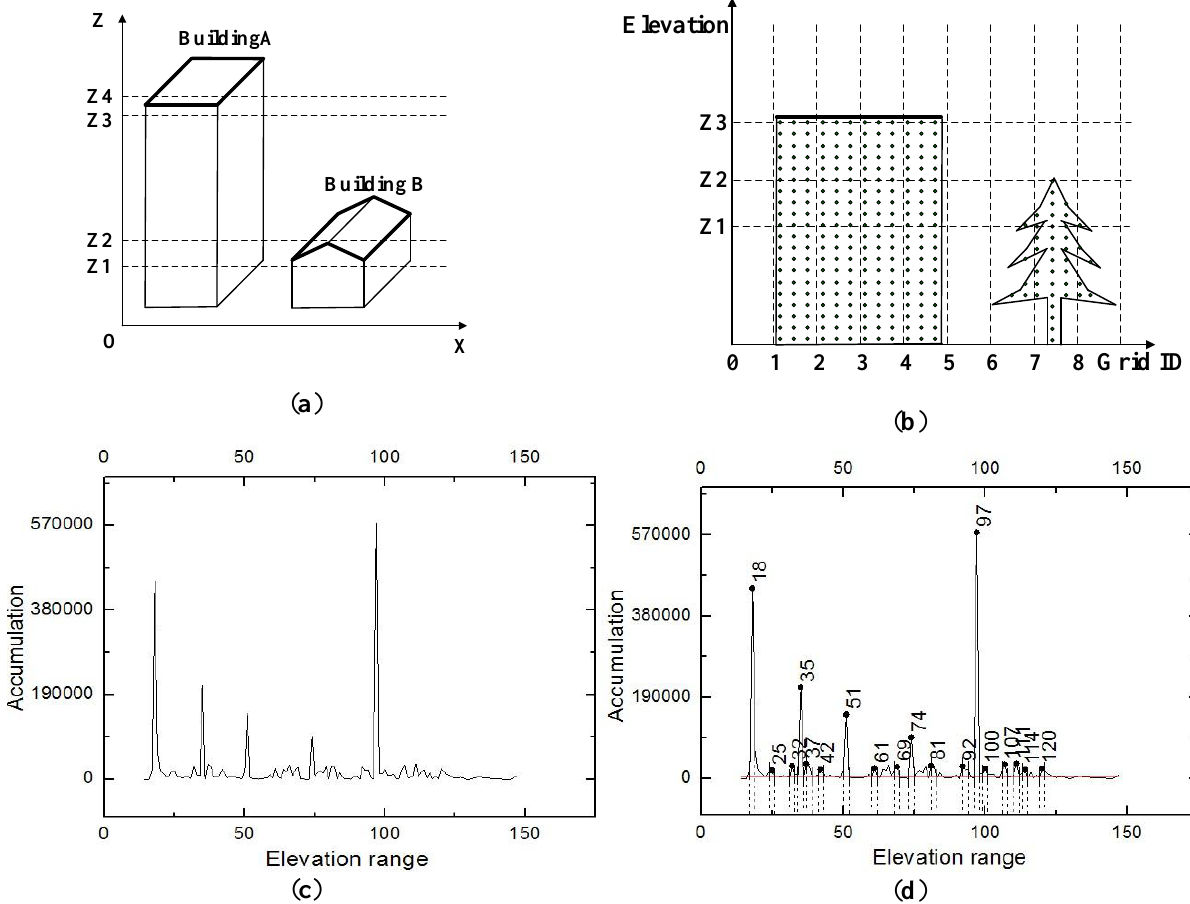
Figure 4. Theory of height value accumulation. ( a ) A sample of building roofs; ( b ) A sample of height value accumulation; ( c ) Height histogram; ( d ) Extraction of elevation range of building